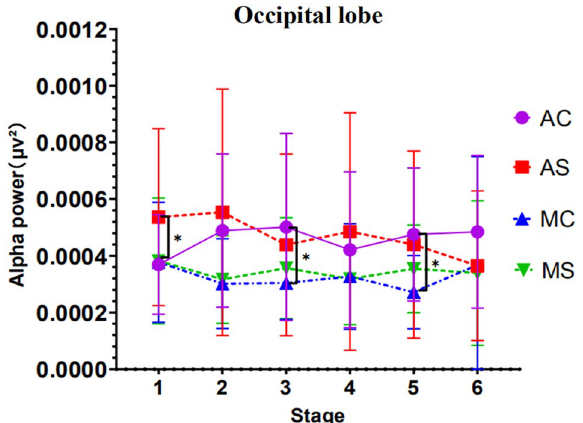
Figure 9. EEG alpha wave power in the occipital region (Note: Vertical bars represent standard errors, * p <